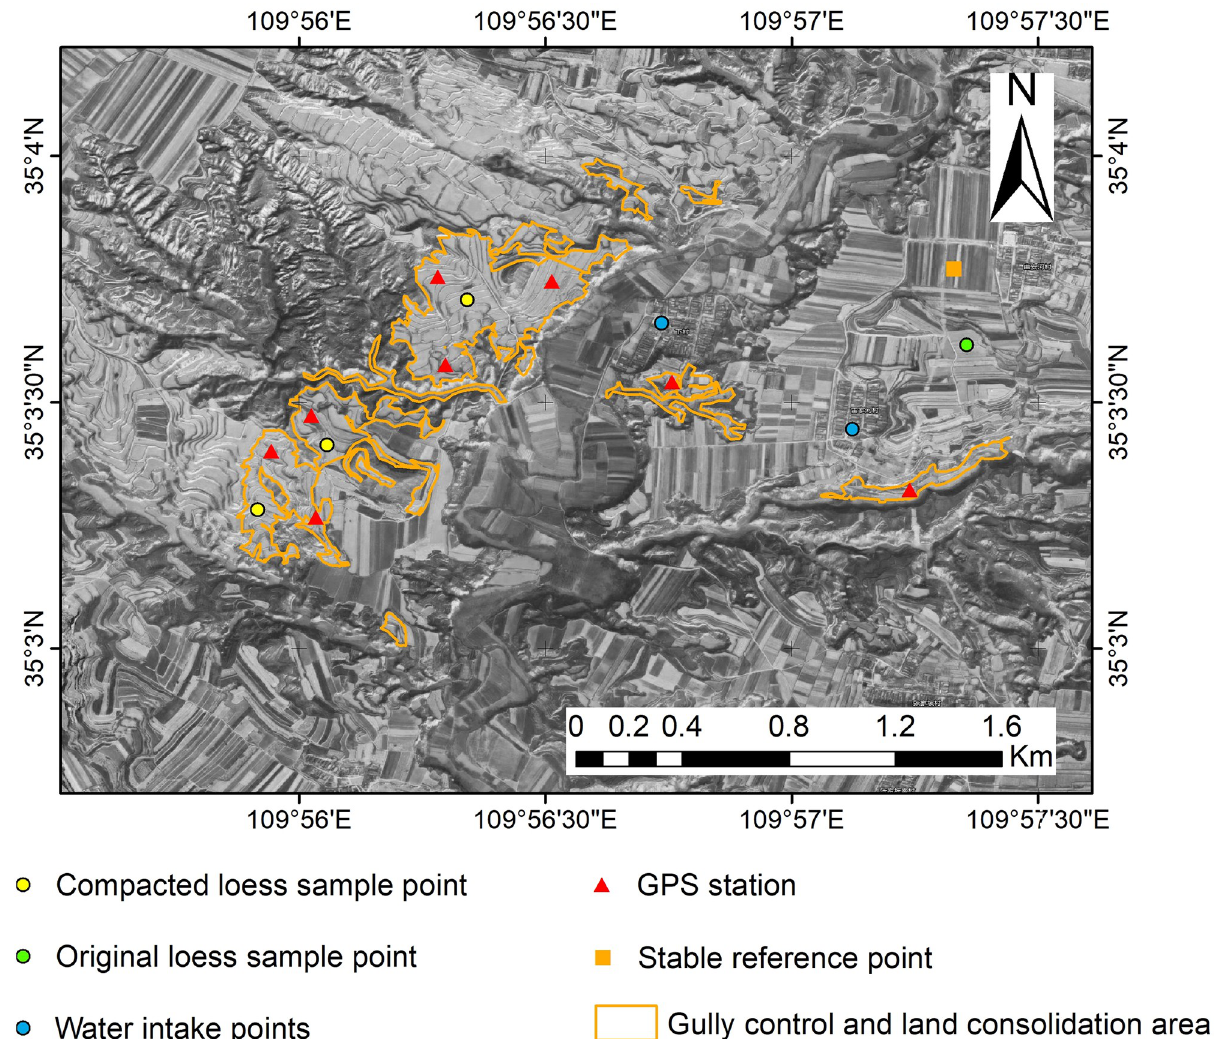
Fig 3. Spatial distribution of different data sampling